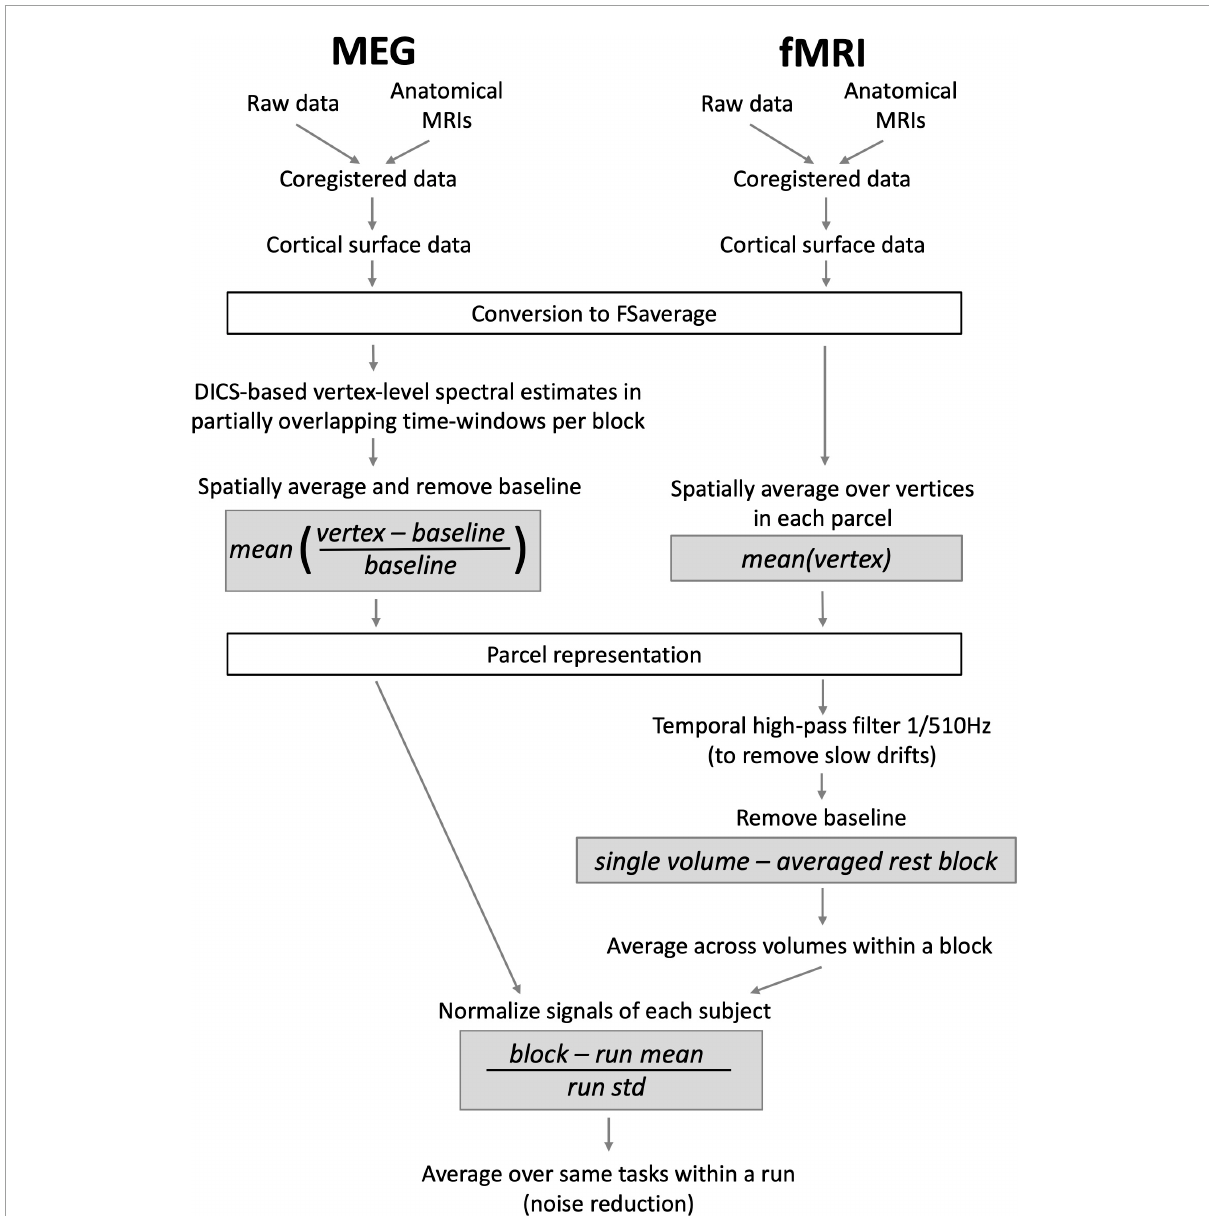
FIGURE1 An outline of MEG and fMRI analysis pipelines, displaying the most important steps and their order. Gray boxes show essential normalizations that aim to equalize the measures obtained with the two modalities.